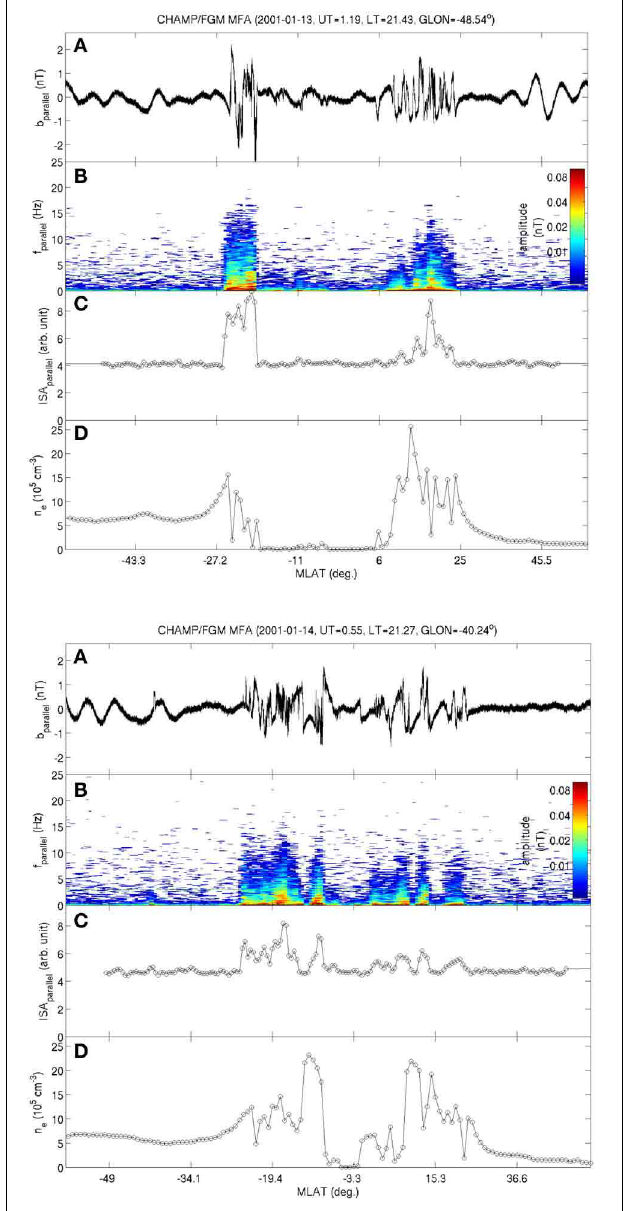
FIGURE 1 | Two examples for observed intermediate-scale plasma structure events. Panel (A) shows the time series of parallel component magnetic field variations. High-frequency fluctuations are caused by rapid passages through plasma fine structures. Panel (B) contains dynamic spectra of the B-field signal; (C) presents the integrated spectral amplitude, ISA, which is used for selecting events. For reference the large-scale electron density distribution is shown in panel (D) . Fine-structures generally coincide with plasma